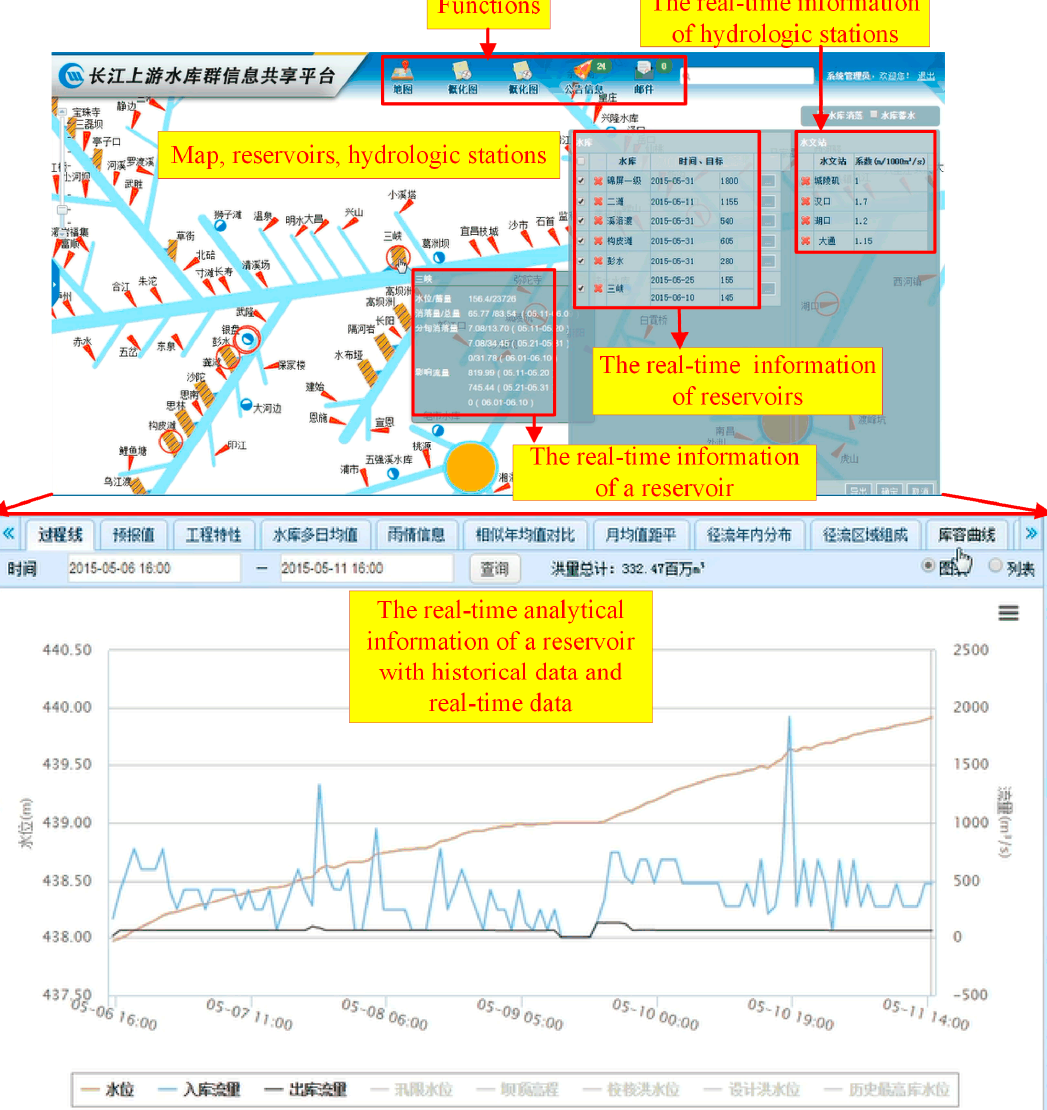
Figure 8. The GeoSensor shares real-time data and information of the reservoirs in an open way.